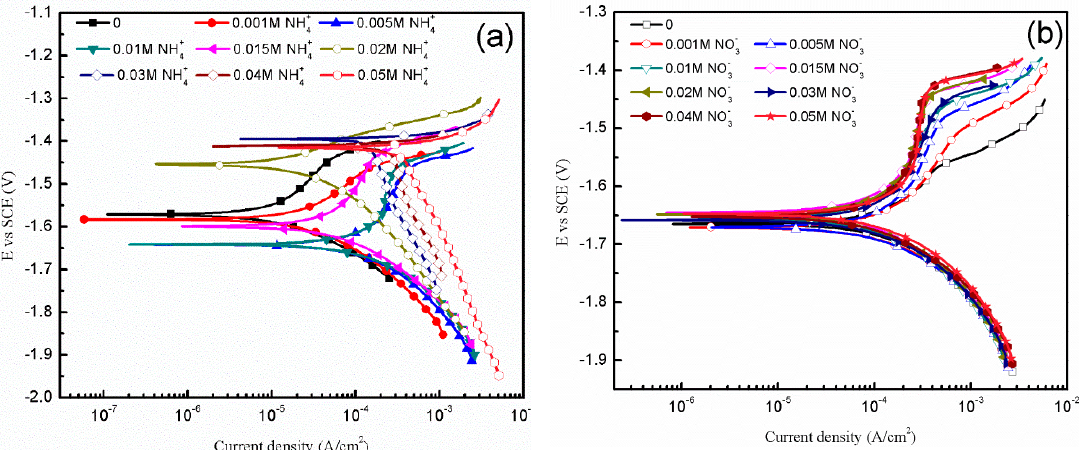
Figure 13. Polarization curves of AZ91D in solutions of different NH +